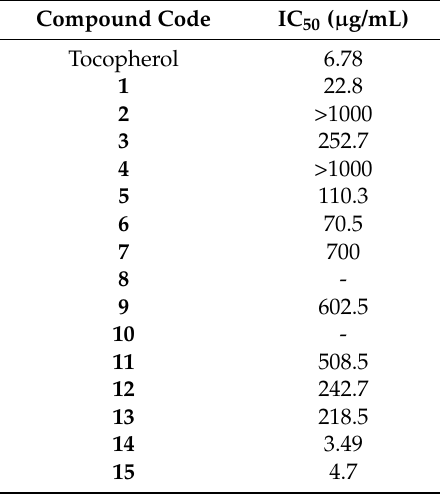
Table 3. The IC 50 value of antioxidant activity for newly synthesized compounds 1 – 15